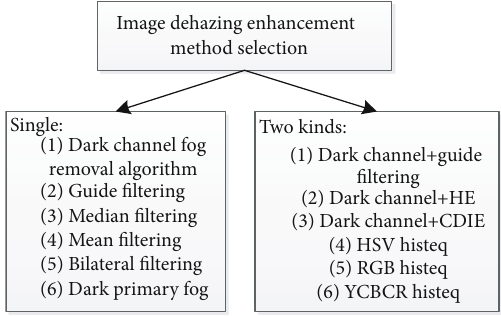
Figure 5: Image processing usage